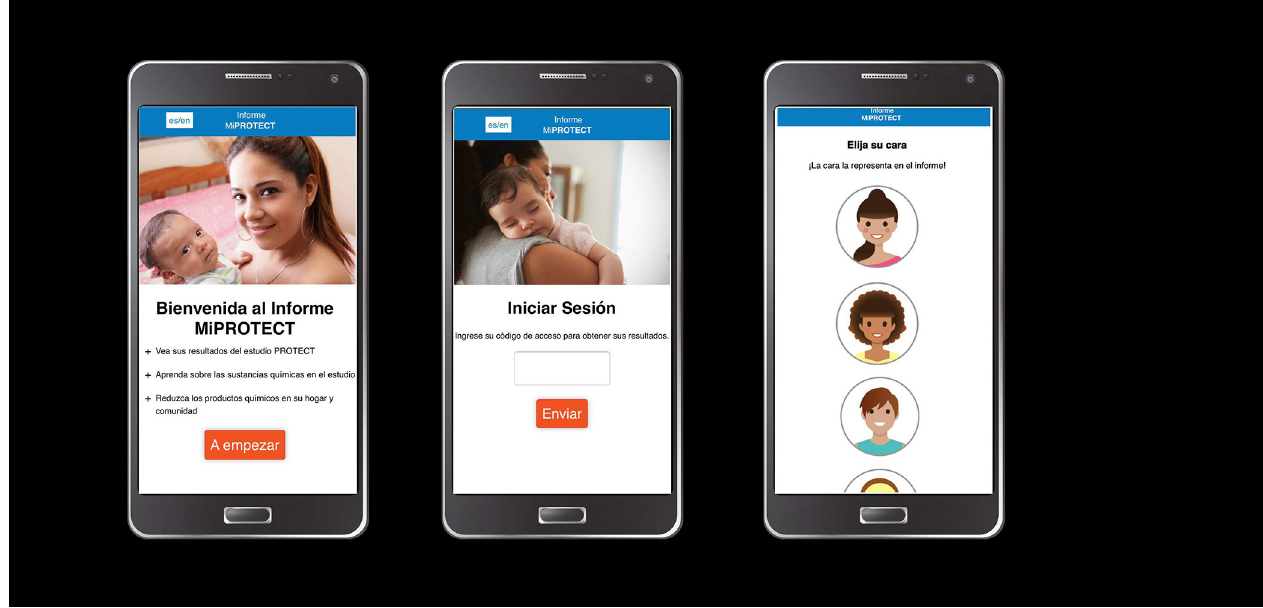
Fig 1. Mi PROTECT mobile platform access and avatar selection.